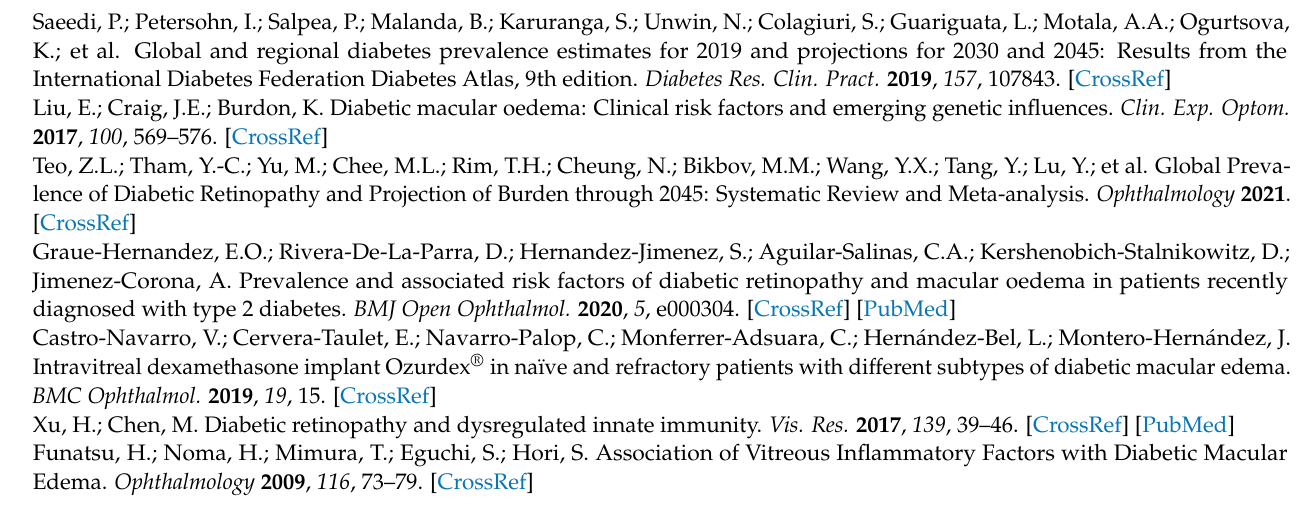
diagnosed with type 2 diabetes. BMJ Open Ophthalmol. 2020 , 5 , 1–11. https://doi.org/10.1136/bmjophth-2019-000304.